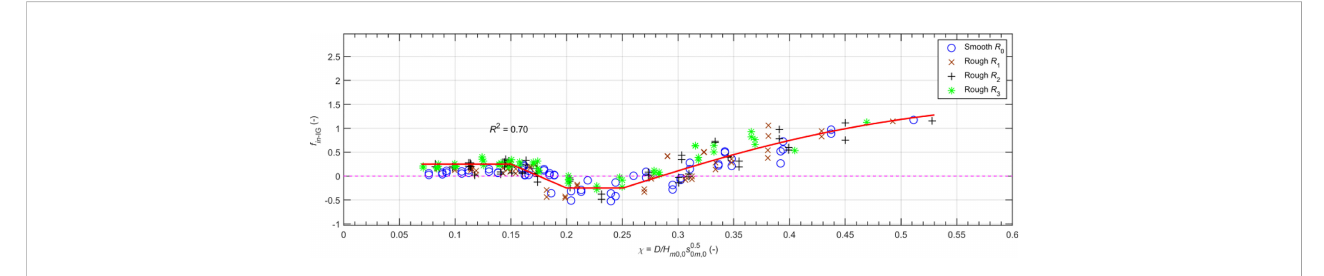
FIGURE 13 Relationship of wave energy conversion coef fi cient f in-IG and relative submergence c